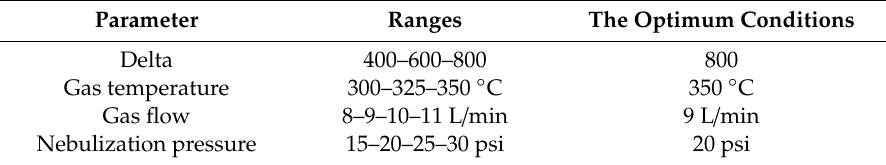
Table 3. Summary of the optimum conditions for ion source